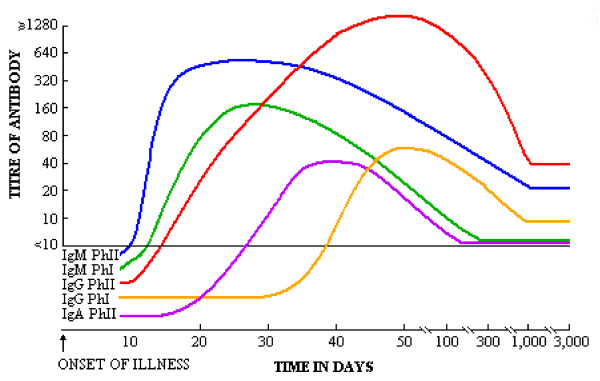
Idealised antibody responses in acute Q fever as measured by IFA13.